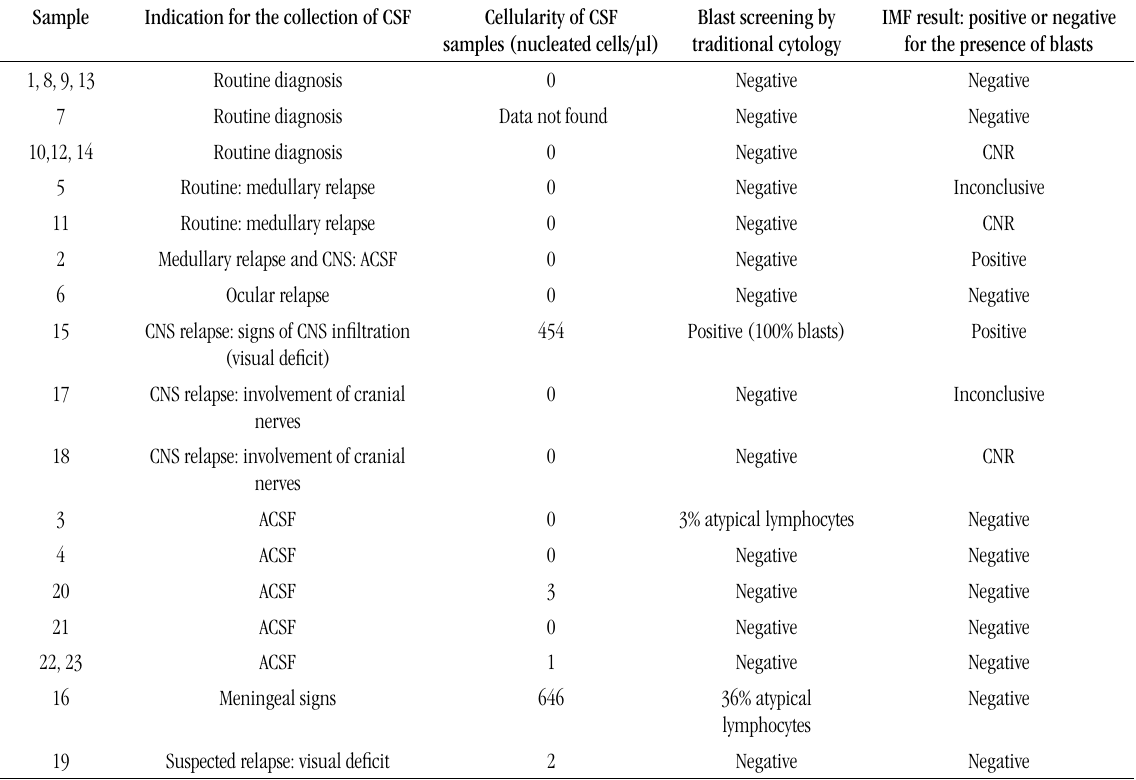
tABLE – Characteristics of 23 samples of CSF from children with acute lymphoblastic